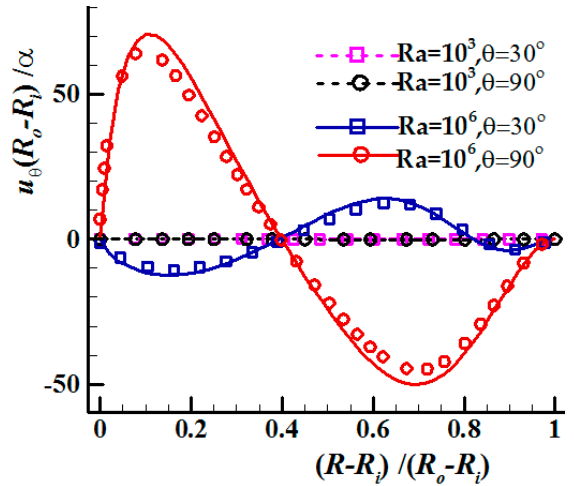
Figure 10. Variation of tangential velocity, u θ , along the gap between the inner and outer hexagonal cylinders at angles, θ = 30 ◦ , and θ = 90 ◦ for AR = 0.6. The symbols represent the corresponding data from Fluent software.